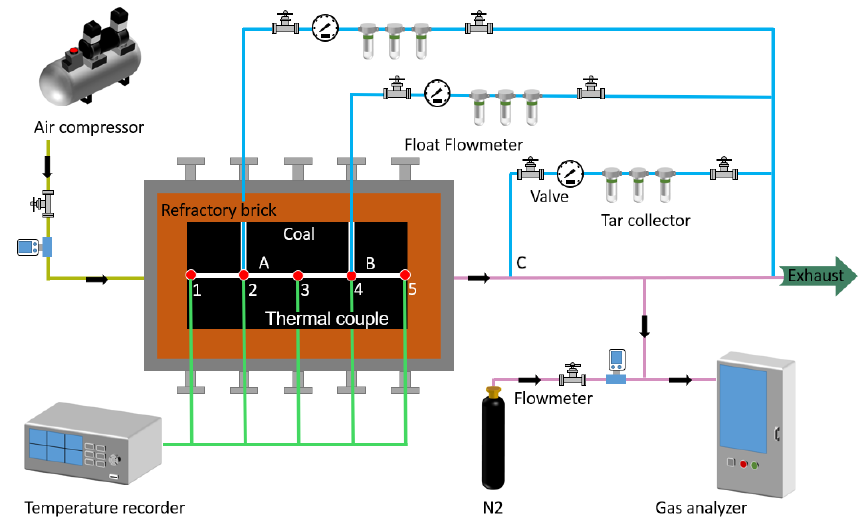
Figure 1. Schematic of the experimental system.